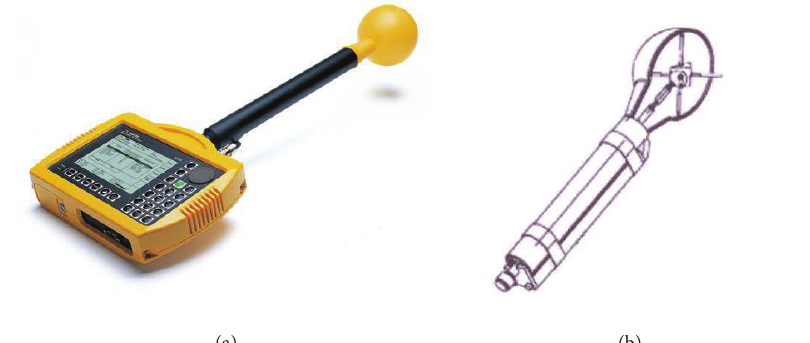
Figure 9: The Narda Model SRM-3006 high frequency selective radiation meter with an isotropic E-field probe. (a) The Narda Model SRM- 3006 E-field meter. (b) Isotropic E-field probe with three axis antennas.